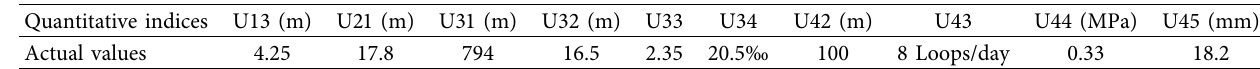
Figure 8: Tunnel geological cross section. Table 7: Actual values of quantitative indices.